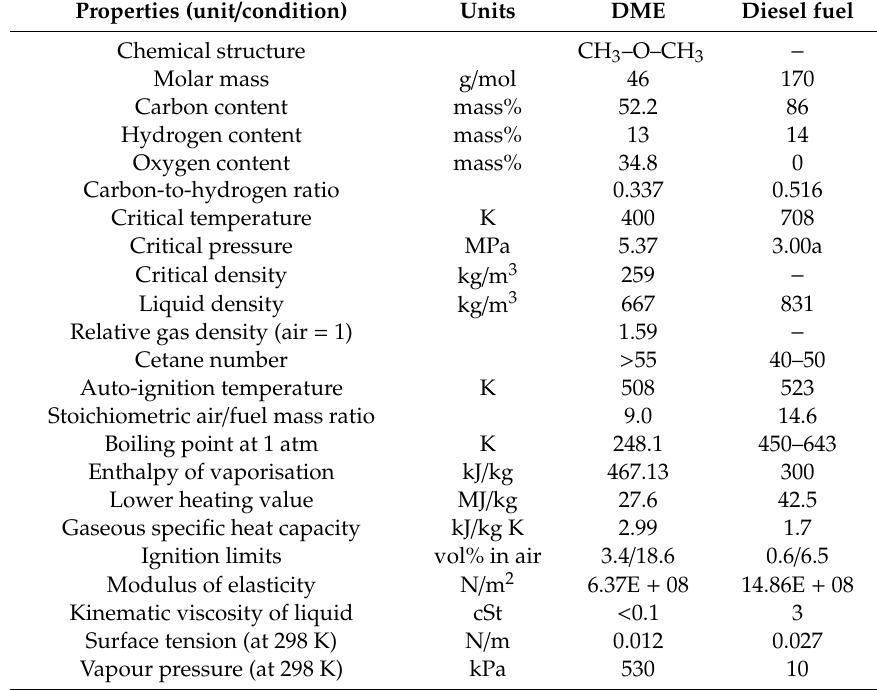
Table 4. Properties of dimethyl ether (DME) and diesel fuel